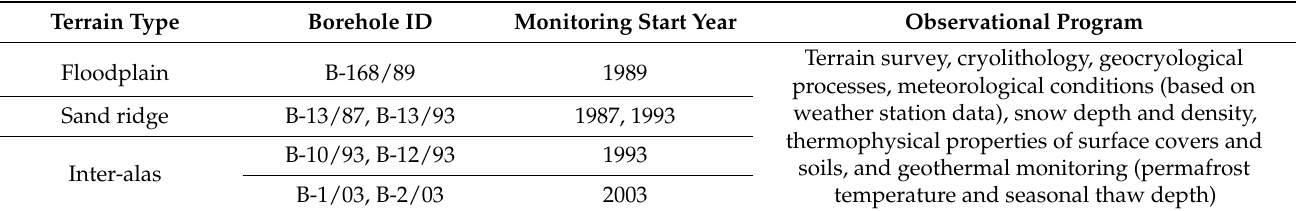
Table 1. Permafrost thermal monitoring sites.